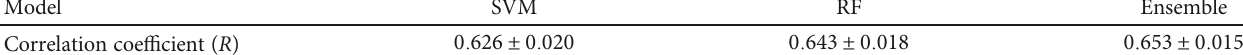
Table 1: Summary of the three models in this work. Note that the same split dataset was used for model training and testing.